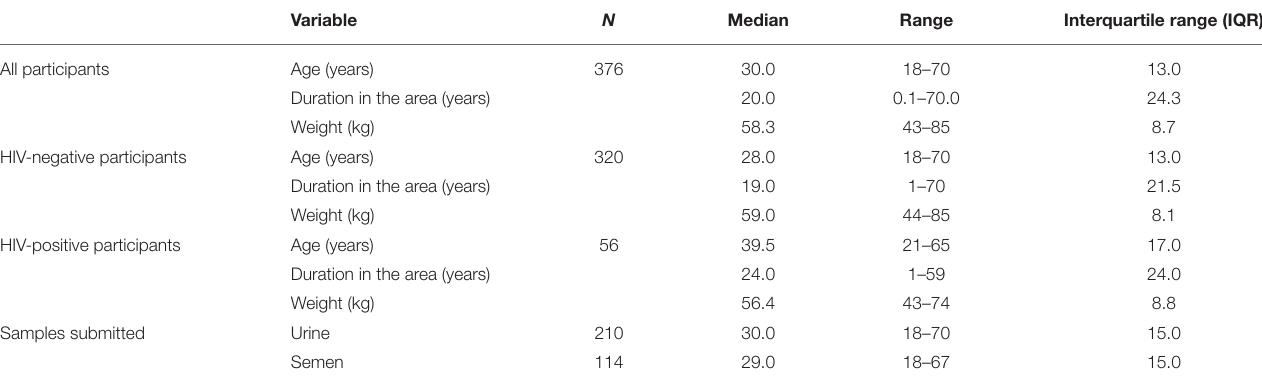
TABLE 1 | Demographic information of the study